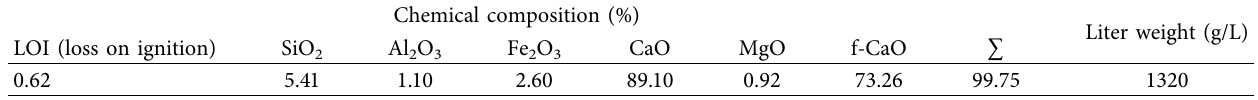
Table 1: Static blasting material components.